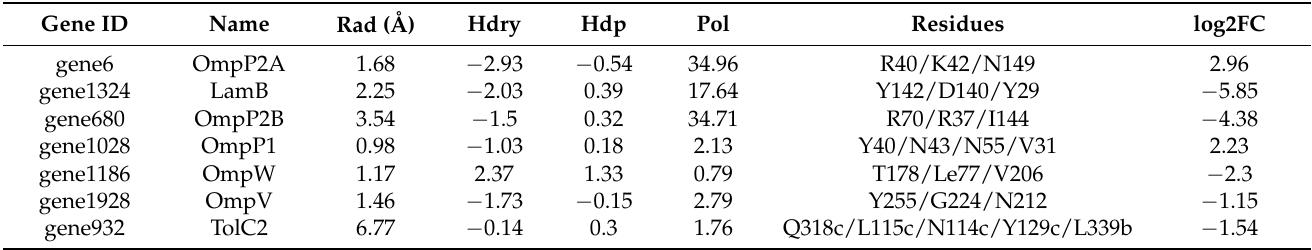
Table 3. DEGs and structural properties of porins.